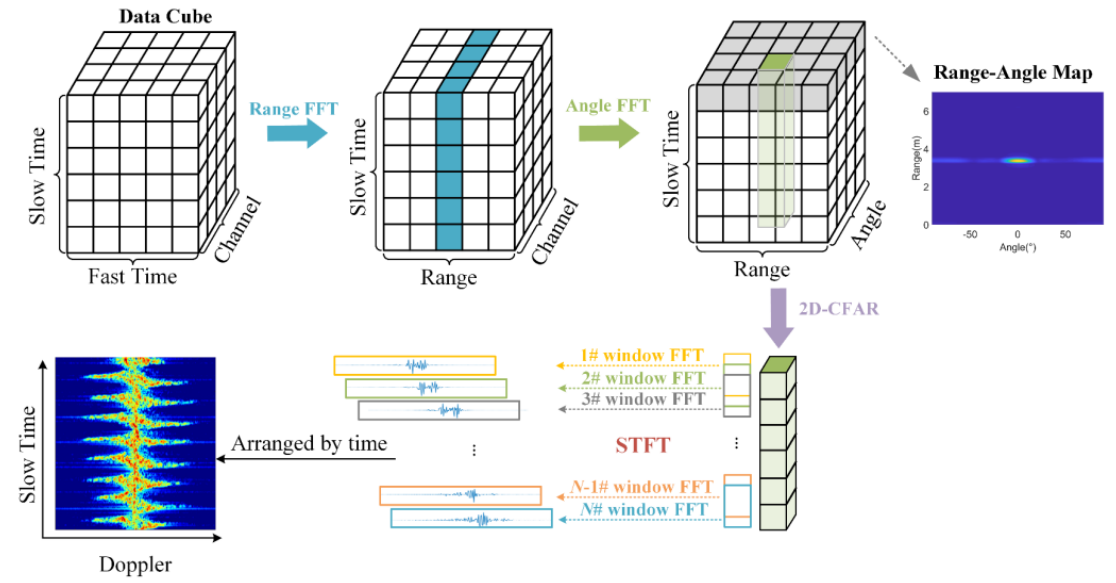
Figure 4. Micro-Doppler processing flow.